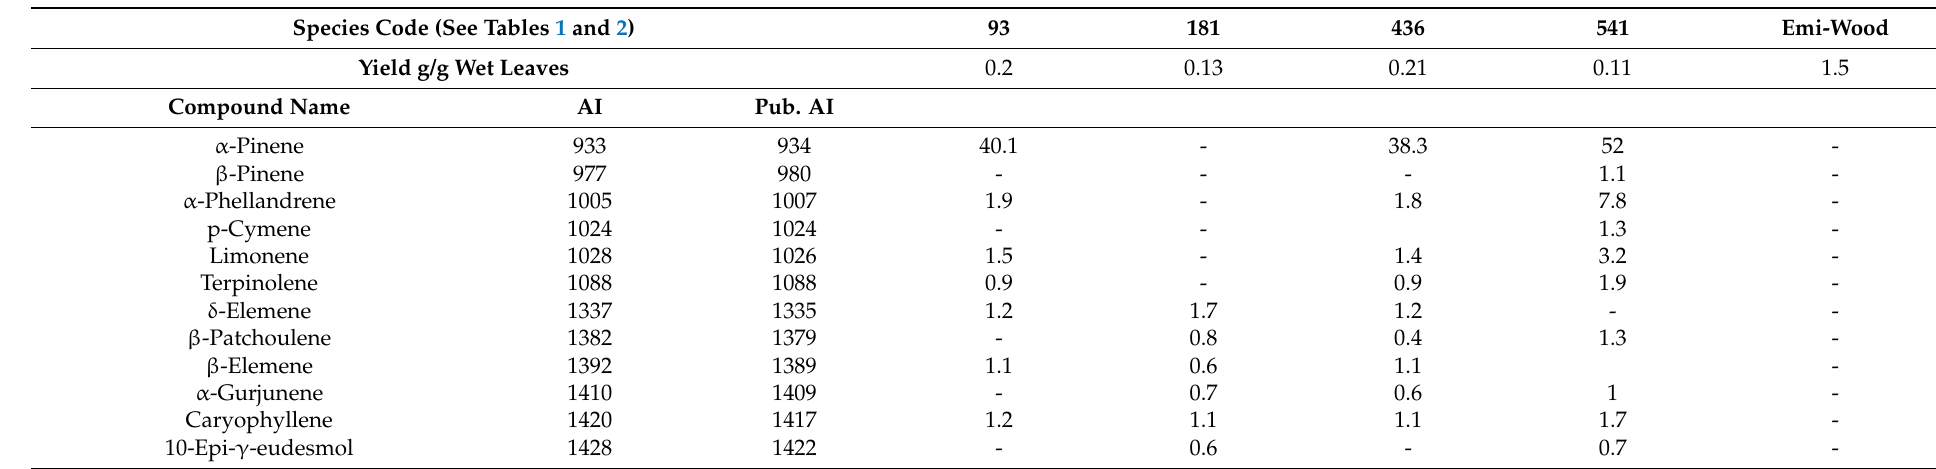
Table 9. Chemistry of essential oils from Eremophila mitchellii